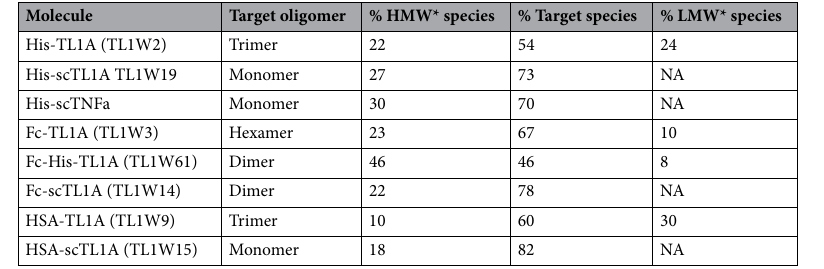
Table 1. Measurement of Monodispersity of TL1A molecules.